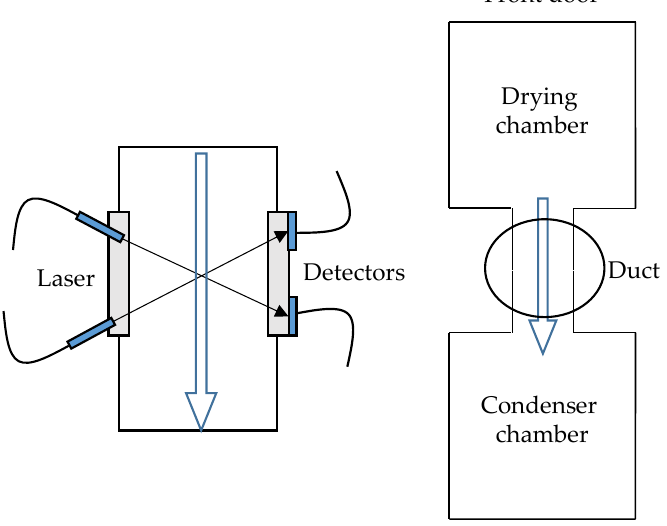
Figure 5. TDLAS setup inside a freeze dryer.